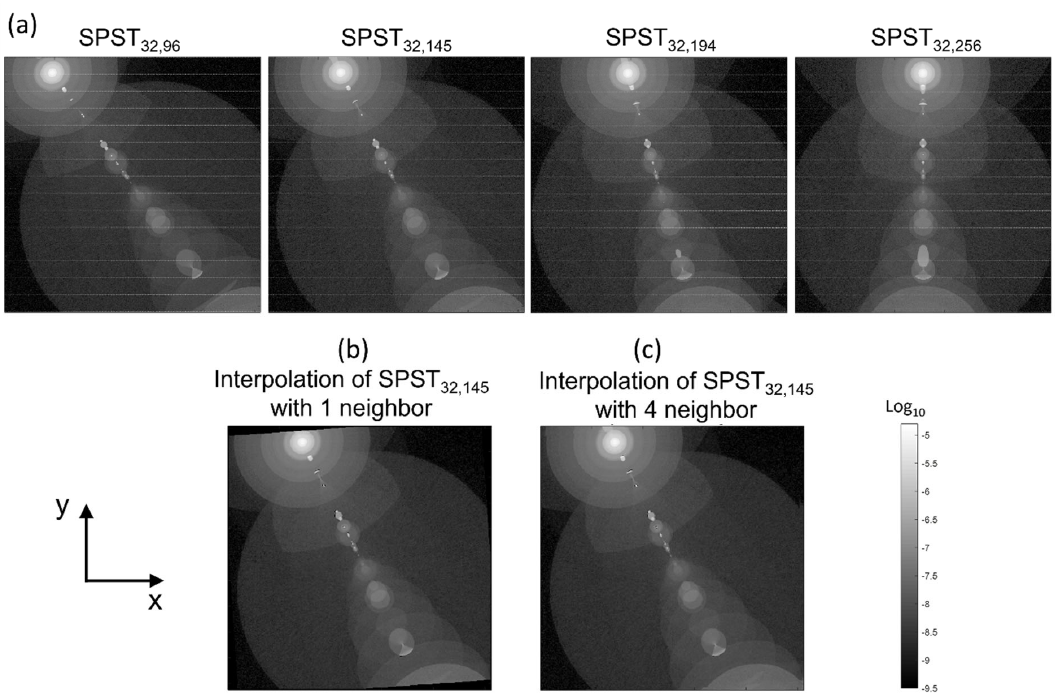
Figure 9. ( a ) SPST i,j with i = 32 and j = 96 to 256. When the field is varied along the horizontal direction, ghosts moves in that direction too, thus their distance from the center all evolve with the same ratio. ( b ) SPST interpolated with one neighbor, with missing signal on the edges. ( c ) SPST interpolated with up to 4 neighbors to fill, with no missing signal on the edges.